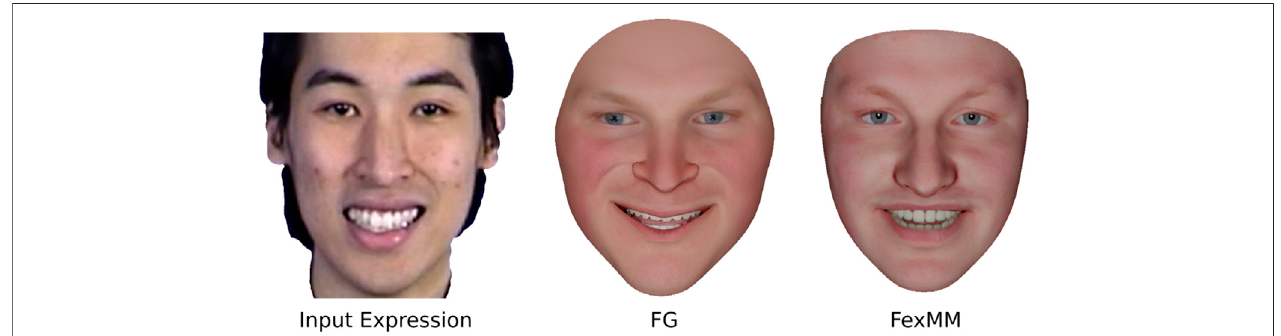
FIGURE 6 | A frame of the input video showing the video-taped person along with individualized and animated avatars. Please note that the person in the input video differs intentionally from the individualized avatar to avoid an effect of identity in the similarity rating